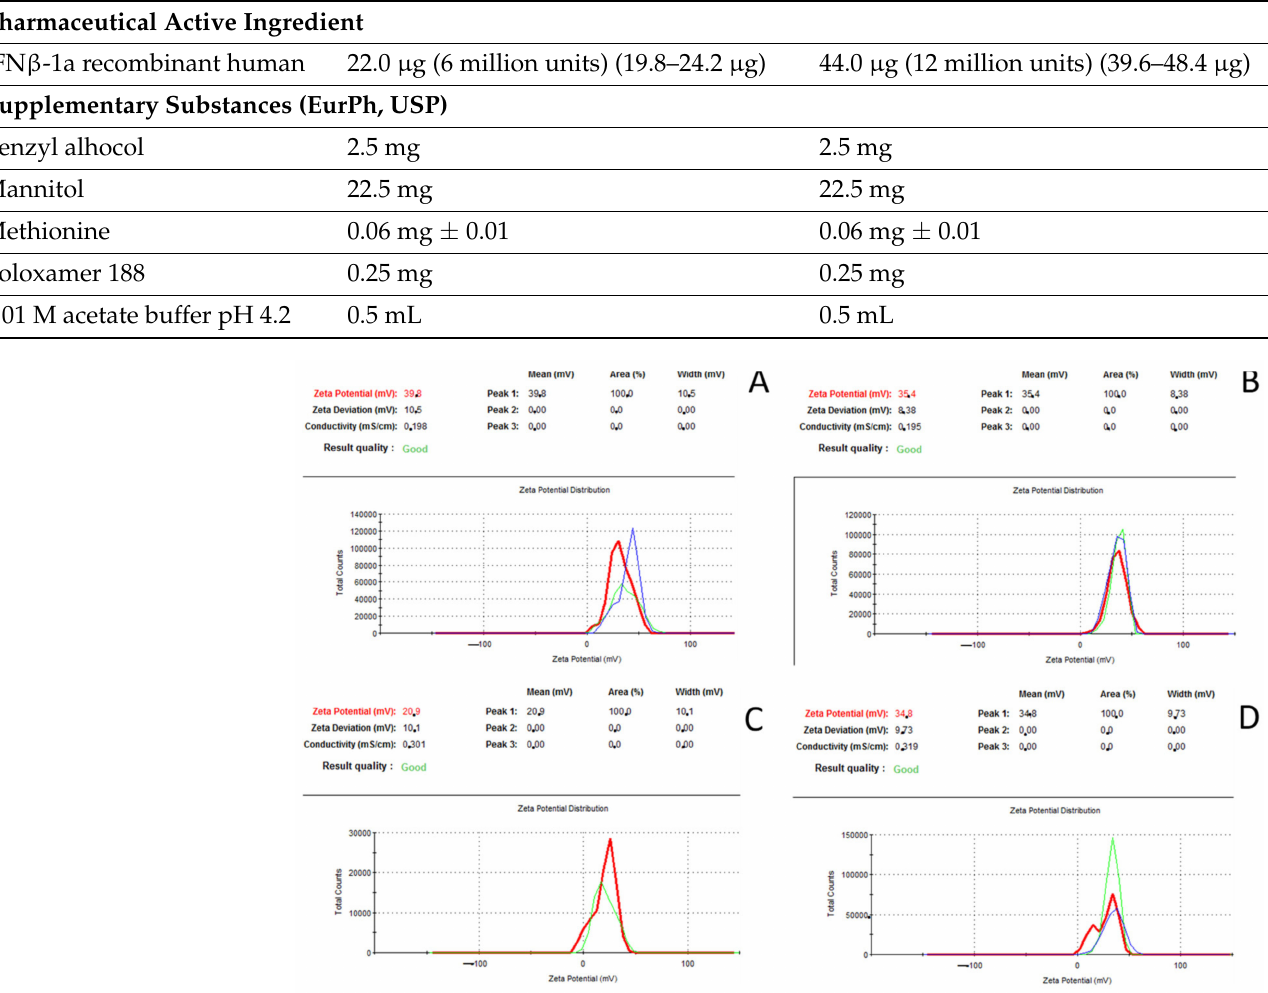
Table 2. Specification of Rebif and ReciGen IFN β -1a in a syringe with volume 0.5 mL.